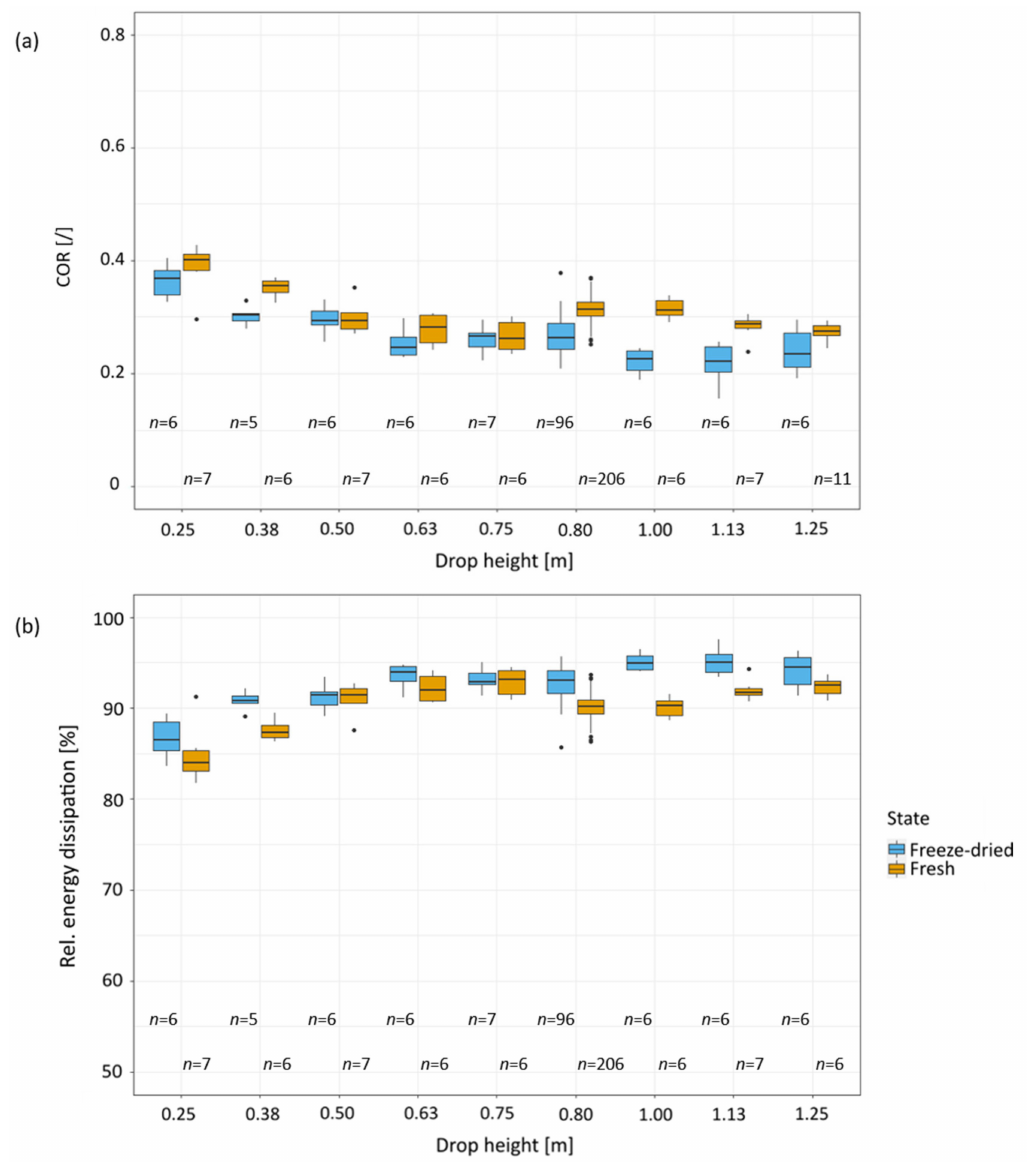
Figure 8. ( a ) Coefficient of restitution (COR) of the impact on fresh and freeze-dried samples of Citrus × limon for different drop heights, and ( b ) relative energy dissipation of fresh and freeze-dried samples of Citrus × limon for different drop heights. All drop-weight tests were performed with a cylindrical impactor with a mass of 0.061